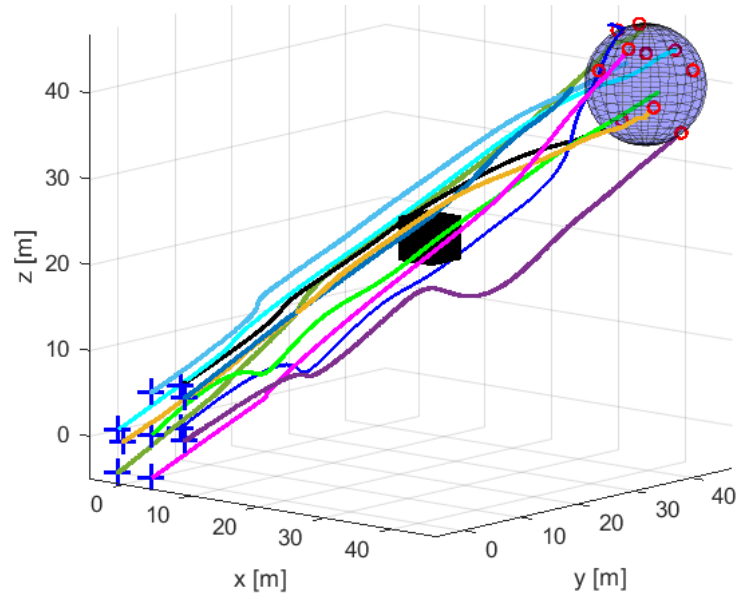
Figure 3. UAV swarm converging to the spherical formation shapes avoiding obstacle.